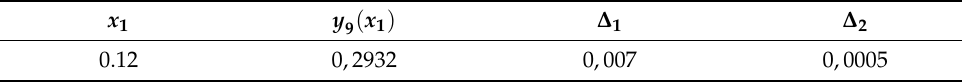
Table 1. Numerical characteristics of an analytically approximate